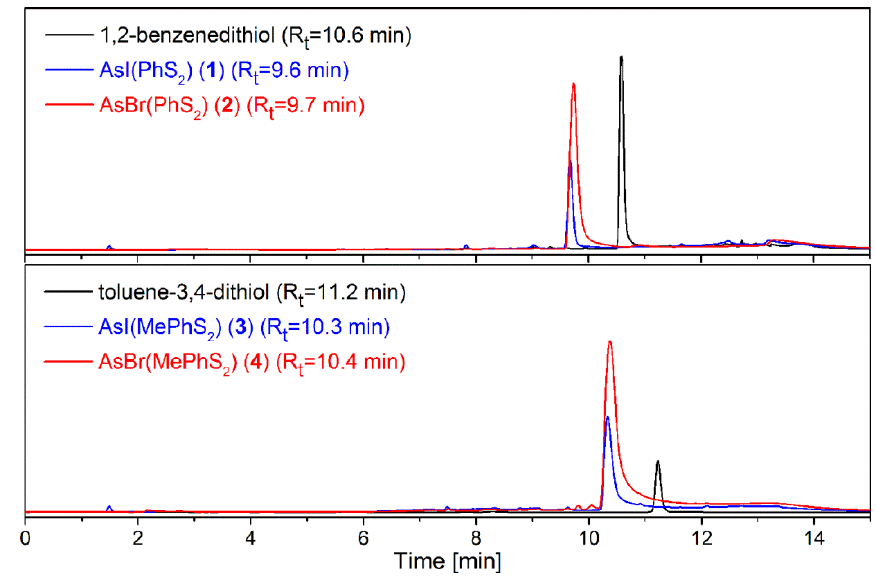
Figure 1. The high-performance liquid chromatography (HPLC) chromatograms of the obtained arsenic compounds.